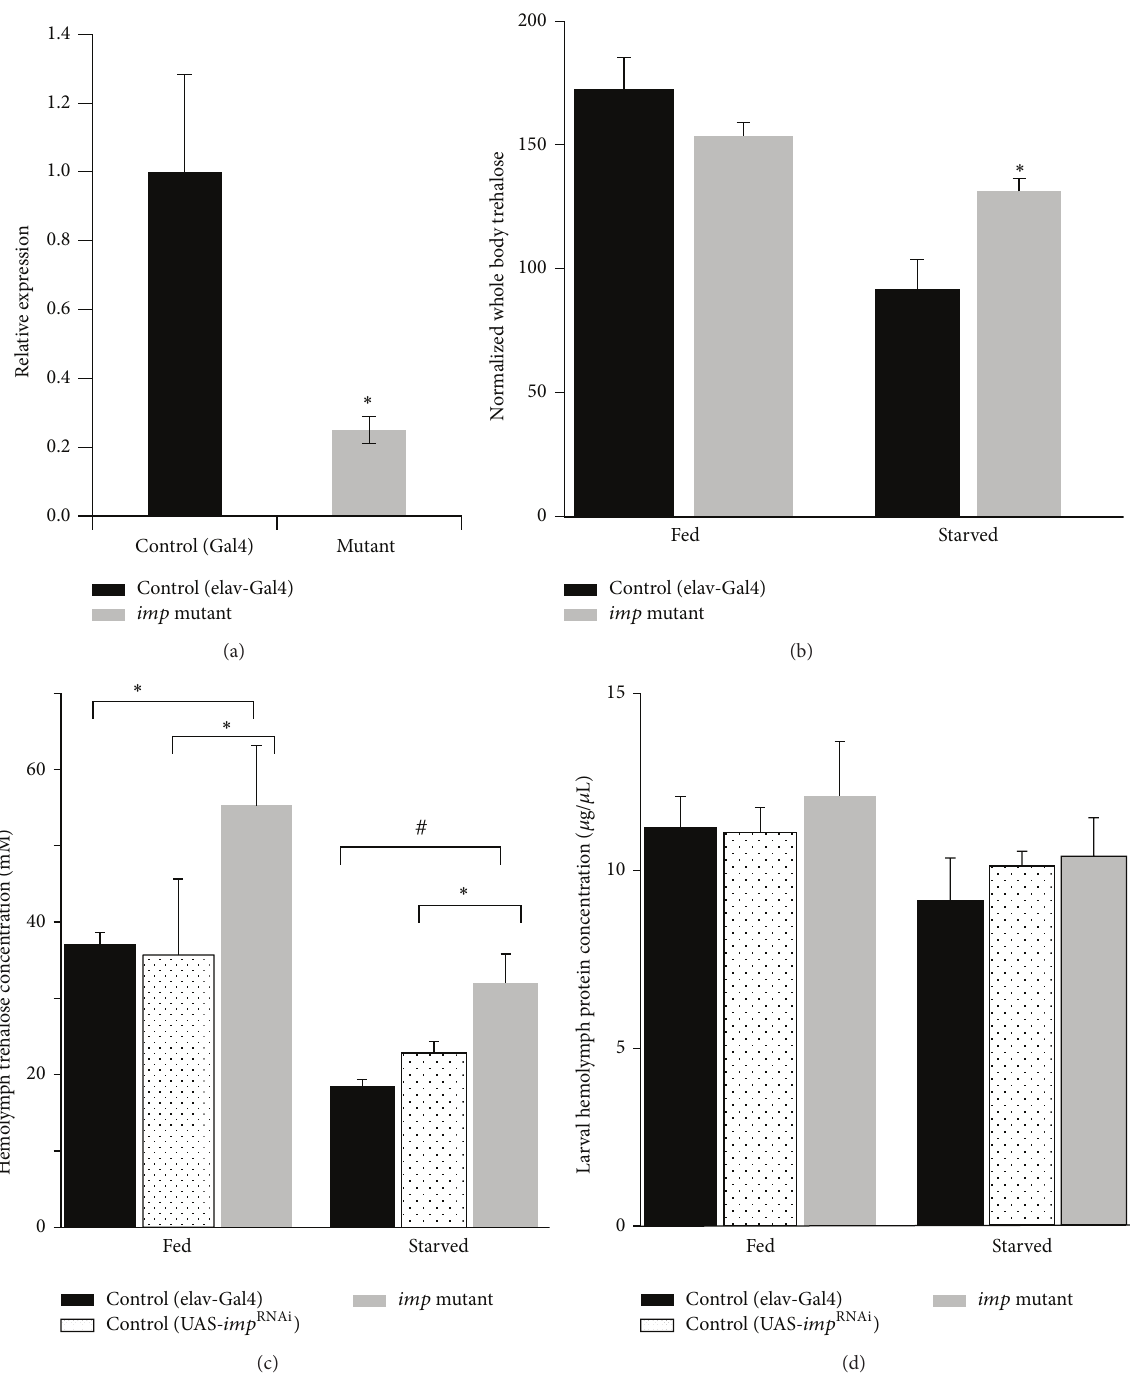
Figure 2: Abnormal sugar metabolism is observed in the imp knockdown larva. (a) imp transcript was analyzed by q-PCR in larvae of the indicated genotypes. It was confirmed that the CNS specific knockdown of imp led to reduction of imp to about one-fifth of that of the controlstrain.(b)Normalizedtrehaloseinwholelarvaehomogenizedpreparationwascomparedinordertoexaminetheoverallcarbohydrate metabolism with protein concentration as an internal reference. The imp mutant shows a delay in trehalose usage in the fasting condition (7-hour fast, 𝑛 = 5 ). (c) Hemolymph trehalose concentration is increased in the imp mutant for both fed and starved condition. The difference is more prominent after 15-hour fasting ( 𝑛 = 6 ). ∗ 𝑃 < 0.05 . # 𝑃 < 0.01 (d) In contrast, hemolymph protein concentration was unchanged for both fed and starved